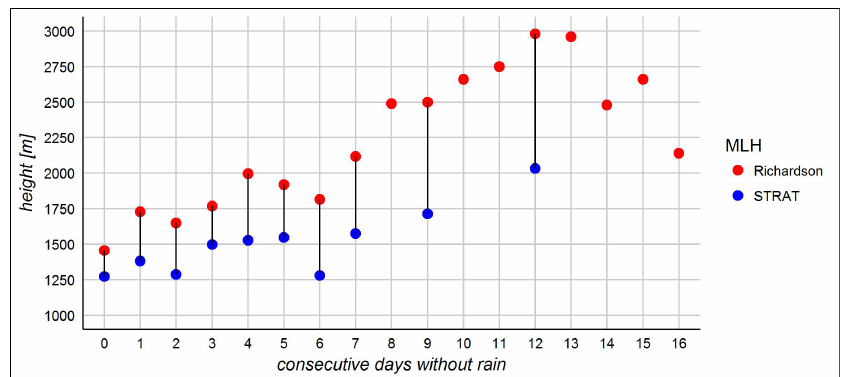
Figure 4. The dependence of drought duration (in number of dry days) on the mean MLH determined by Richardson and STRAT methods.